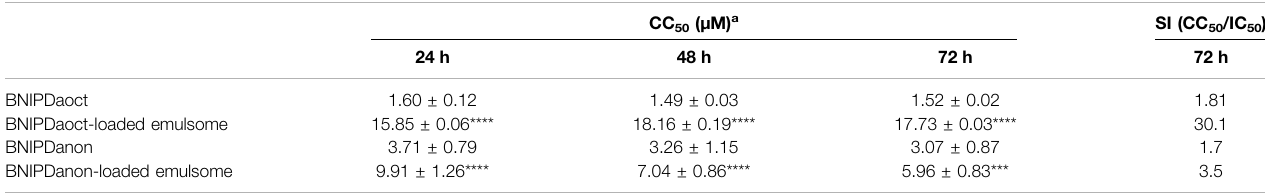
TABLE 3 | The 50% cytotoxic concentration (CC 50 ) of free BNIPDaoct, BNIPDaoct-loaded emulsomes, free BNIPDanon, and BNIPDanon-loaded emulsomes on macrophages after 24, 48, and 72 h